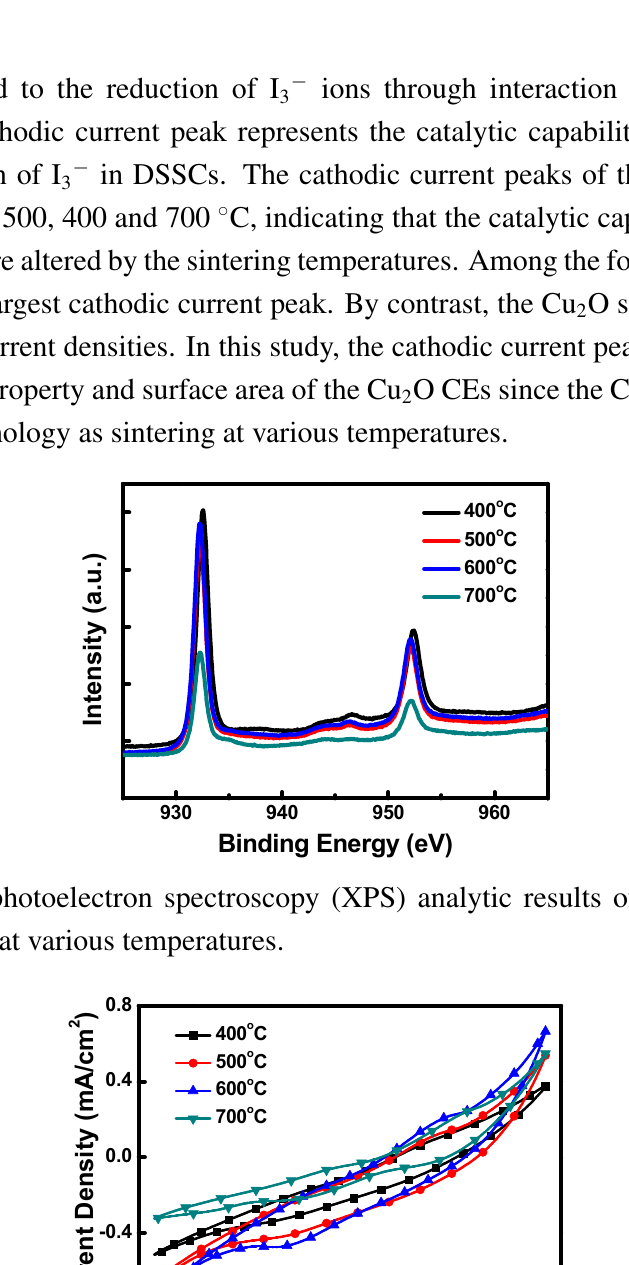
Figure 7. The cyclic voltammograms (CV) of the Cu 2 O counter electrodes sintered at various temperatures.